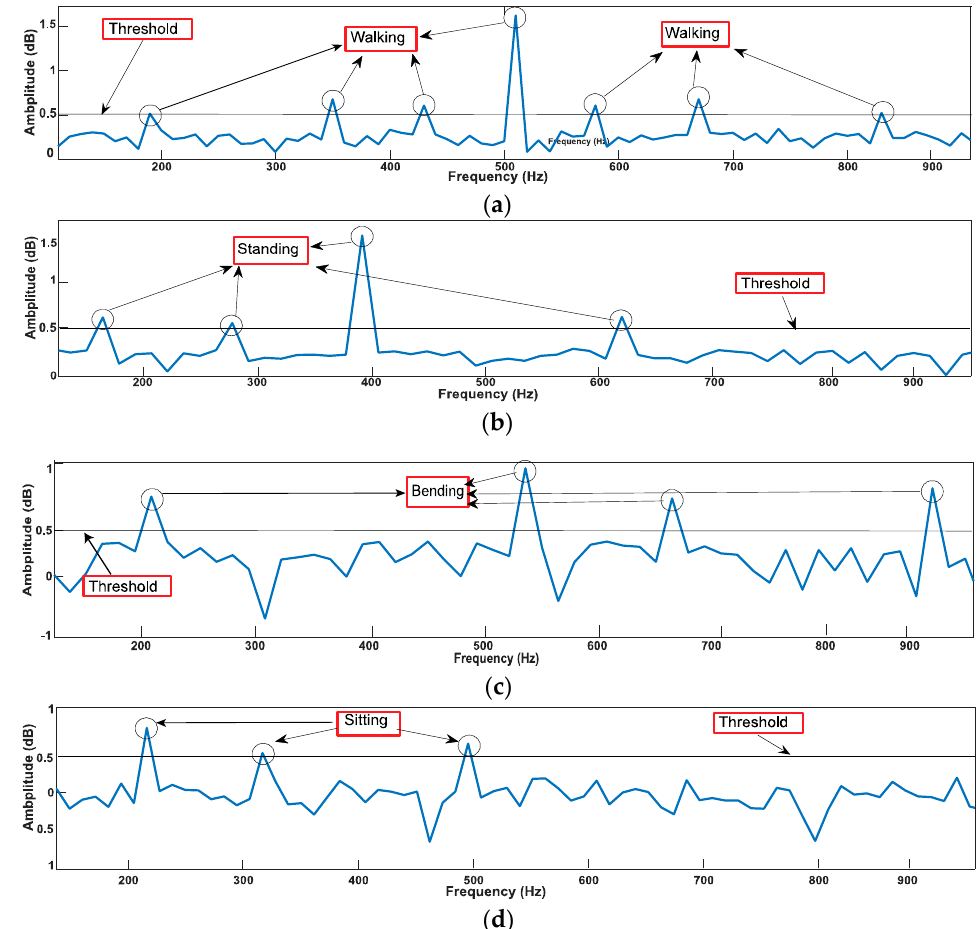
Figure 11. Identification of sideband peaks for pose estimation while ( a ) walking ( b ) standing ( c ) bending ( d ) sitting.